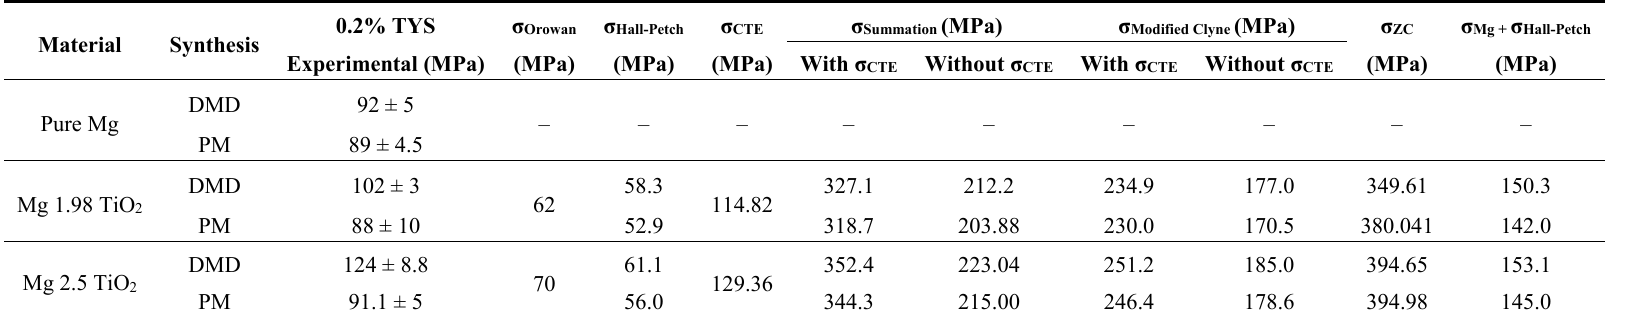
Figure 7. Experimental and Predicted TYS values of DMD and PM synthesized Mg/TiO 2 nanocomposites. Table 8. Contribution of different strengthening mechanisms and predicted values of tensile yield strength of DMD and PM synthesized Mg/TiO 2 nanocomposites using analytical